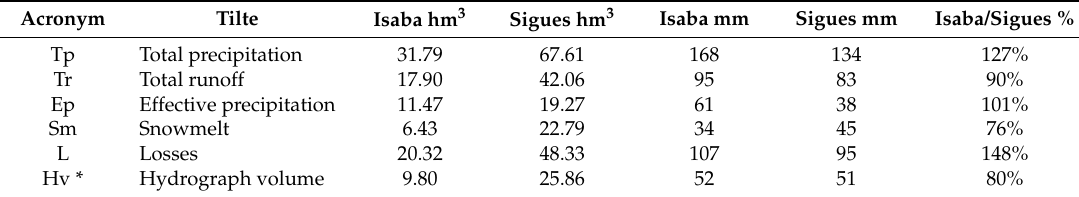
Table 4. Benchmarking of the water budget (within the range 0–200 h) in the stream gauges of Isaba and Sigues. Acronym Tilte Isaba hm 3 Sigues hm 3 Isaba mm Sigues mm Isaba/Sigues % Tp Total precipitation 31.79 67.61 168 134 127% Tr Total runoff 17.90 42.06 Effective precipitation Snowmelt Losses 20.32 48.33 107 95 148% Hv * Hydrograph volume 9.80 25.86 52 51